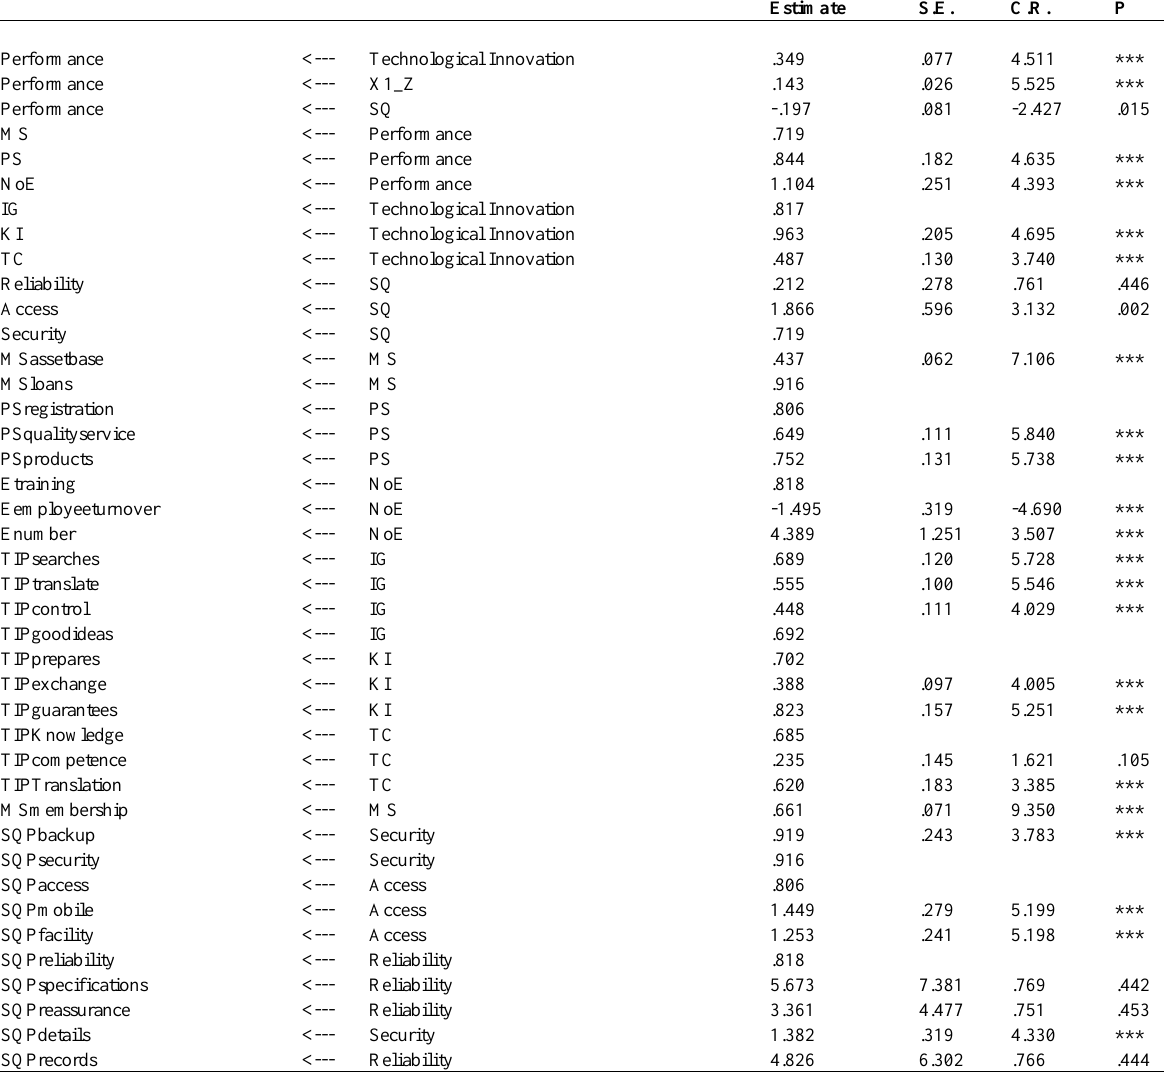
Table 10 is a further statistical analysis of the estimated regression weights with critical ratios to assess the significance of the estimates. The Critical ratios were used to test the significance of the coefficient estimates. The results of this SEM model support the results from the MMR model as it also revealed a significant moderating effect due to the introduction of the interaction term. Both technological innovation ( 𝛽 =0.349, /C.R./= 4.511, p=0.019) and service quality ( 𝛽 =-0.197, /C.R./= 2.427, p=0.015) have significant regression weights as shown by the critical ratios above 1.96. The regression weights of the interaction between service quality and technological innovation promoters ( 𝛽 =0.143, C.R.= 5.525, p=***) also had a Critical ratio greater than the 1.96 standard normal Z-score this implied that service quality practices significantly moderate the relationship between performance and technological innovation promoters. Table 10: Moderated Regression Weights for the SEM on Technological innovation, Service Quality and performance Estimate